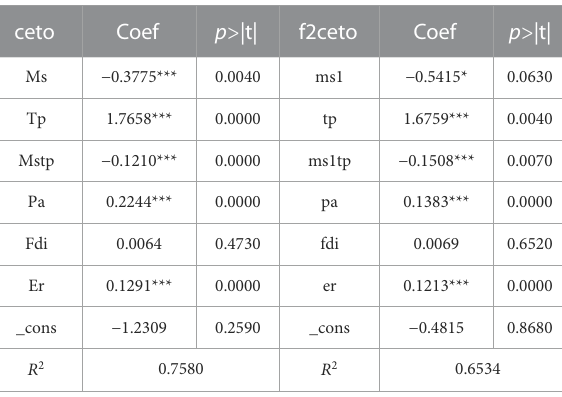
TABLE 6 General adjustment effect analysis of population agglomeration on emission reduction effect of industrial structure